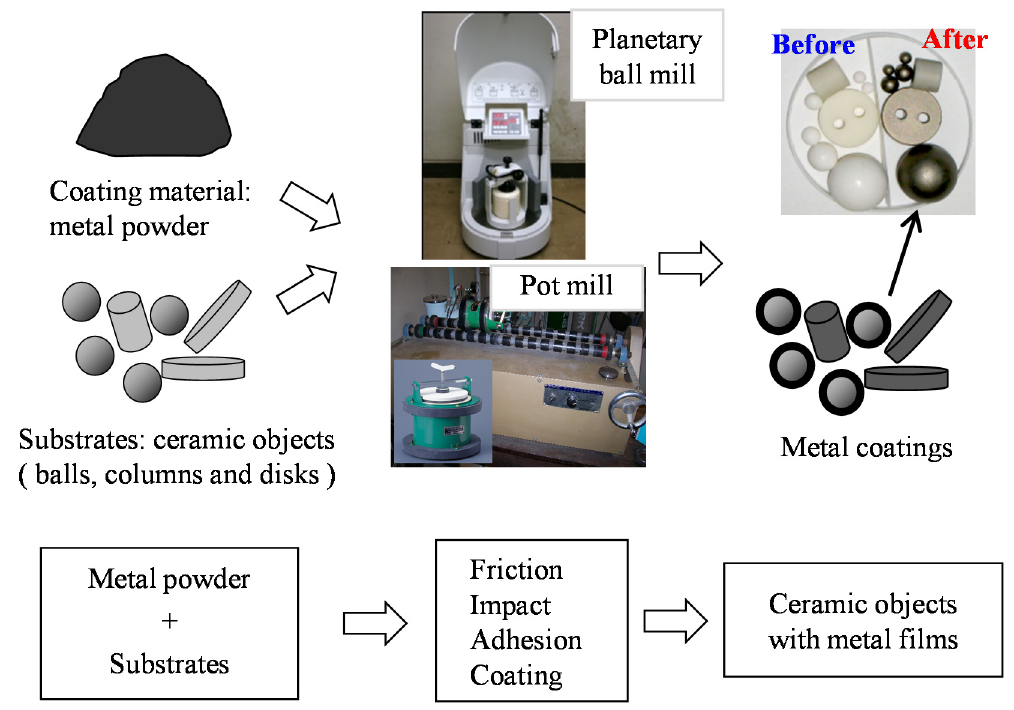
Figure 1. Schematic diagram of fabricating metal coatings by mechanical coating technique (MCT).